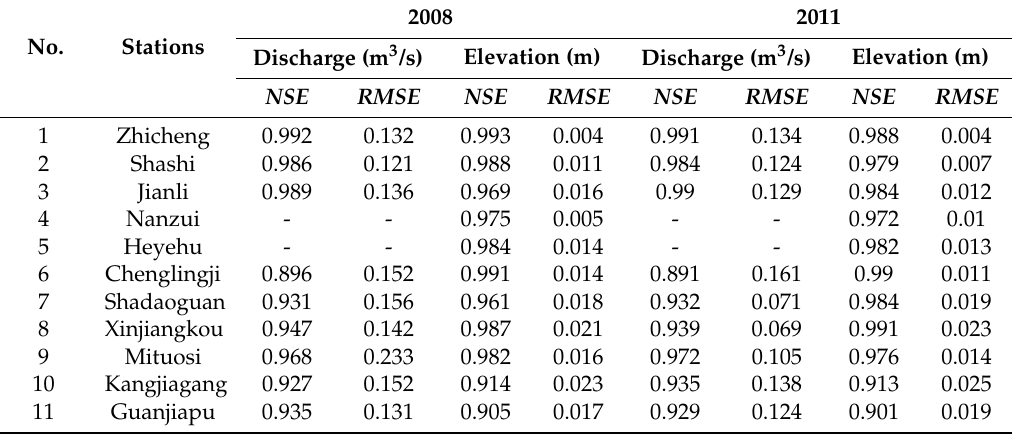
Table 3. Computed results of Nash-Sutcliffe efficiency coefficients ( NSE ) and the normalized root mean squared error ( RMSE ) at the main gauging